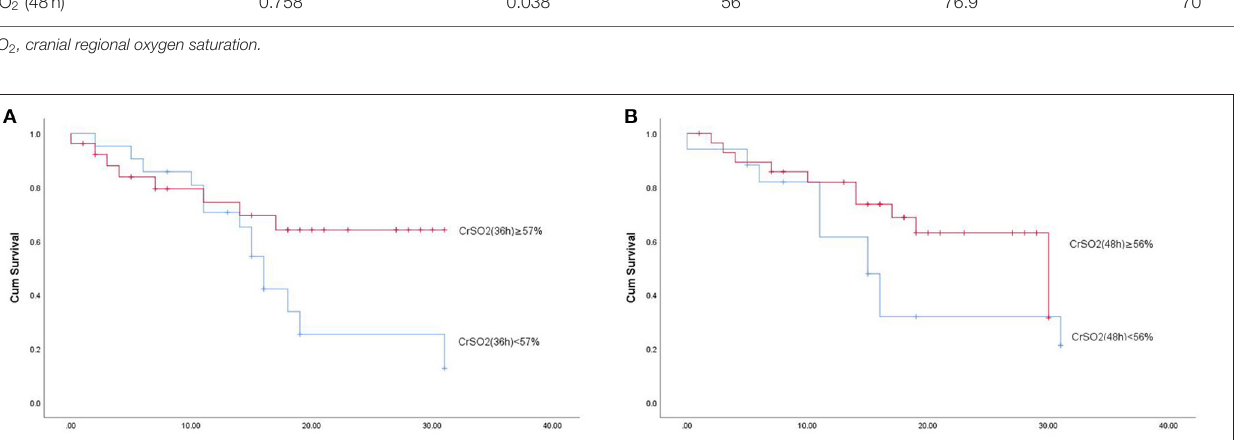
related to the variation in abdominal oxygen in children, which is susceptible to the influence of abdominal bloating, peritoneal dialysis, and urine